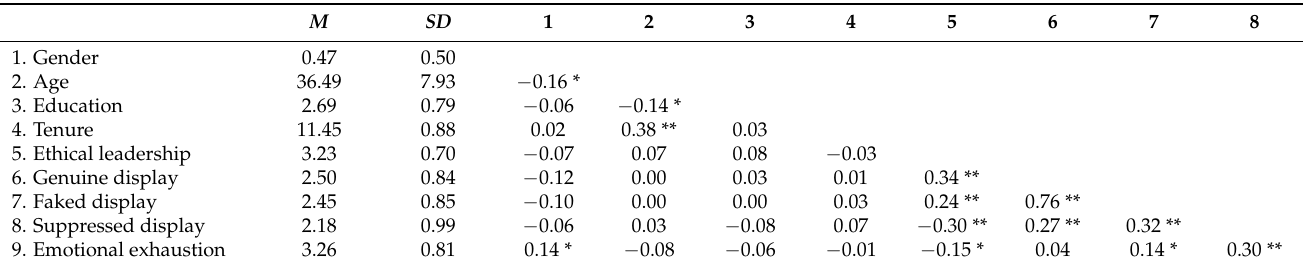
Table 1. Descriptive statistics, and correlations among variables ( N = 259).